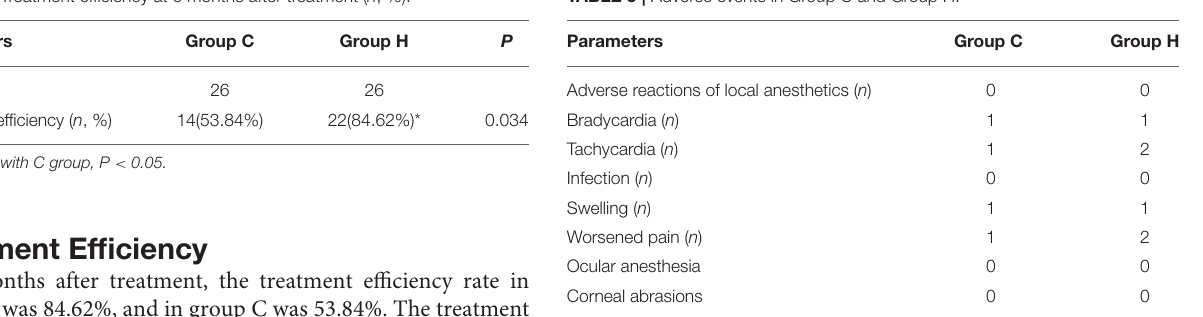
TABLE 4 | Treatment efficiency at 6 months after treatment ( n , %). TABLE 5 | Adverse events in Group C and Group